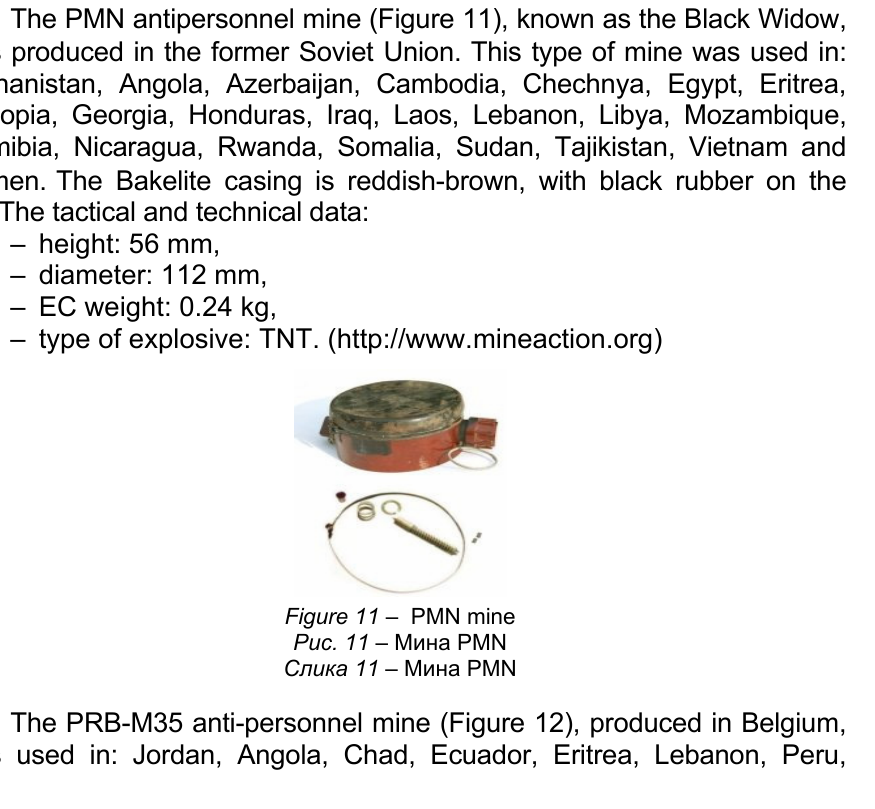
Figure 10 – P4 Mk1 mine Рис . 10 – Мина P4 Mk1 Слика 10 – Мина P4 Mk1